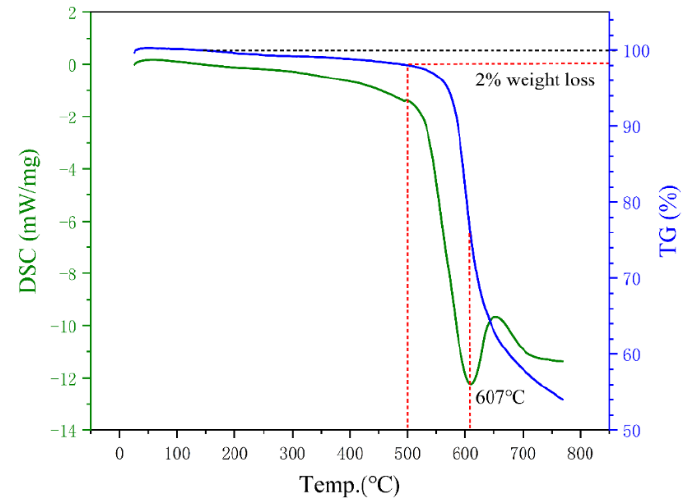
Figure 10. Kinetic curves of thermal decomposition of PI in argon. Figure 11 is the XRD pattern of Fe-Si-Cr SMCs with different annealing temperatures. Similar to Fe-Si-Cr powder, three sharp characteristic peaks (110), (200), and (211) are detected, and the phase composition is mainly α -Fe (Si, Cr) solid solution and Fe 3 Si. It can be seen that annealing only eliminates the internal stress of SMCs without changing their phase composition.